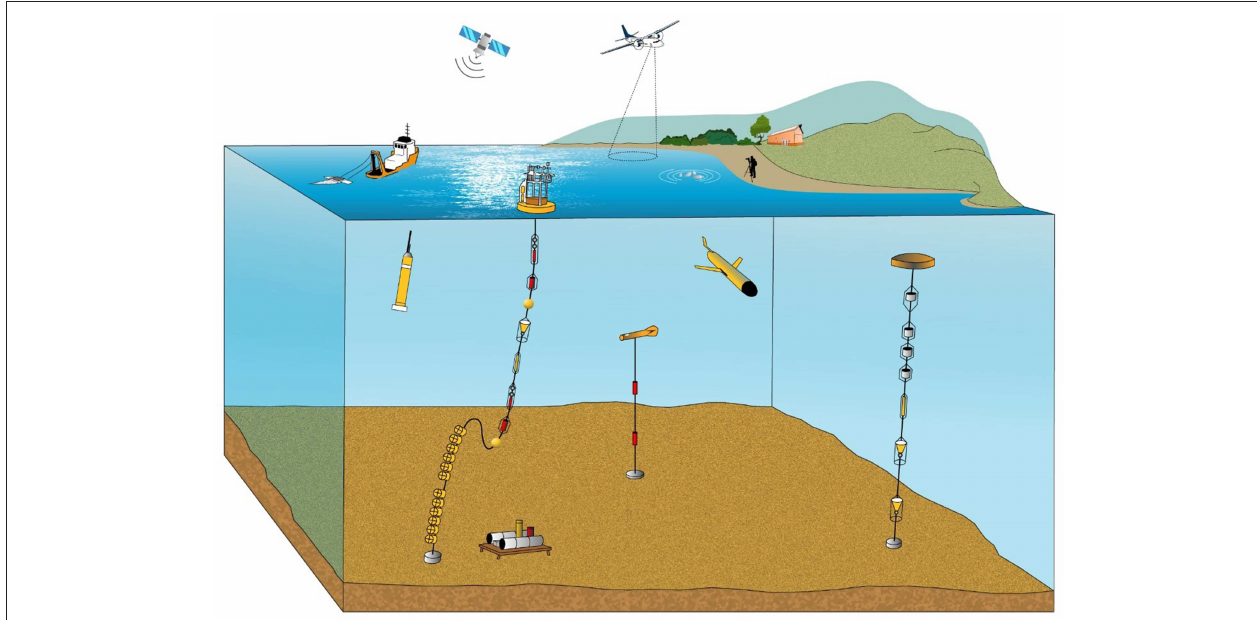
FIGURE 6 | Schematic of the various observation platforms currently in use and on which a variety of sensors and samplers can be carried (Courtesy Kate Davis) (Lampitt has permission to use this